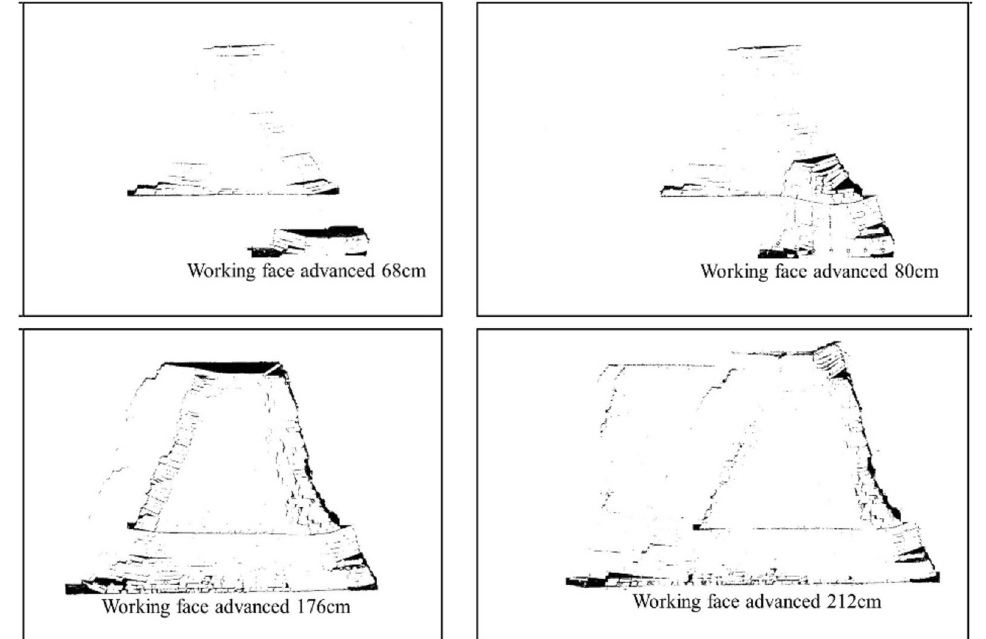
Figure 7. Binary diagram of 3-1 coal seam mining fissure development.